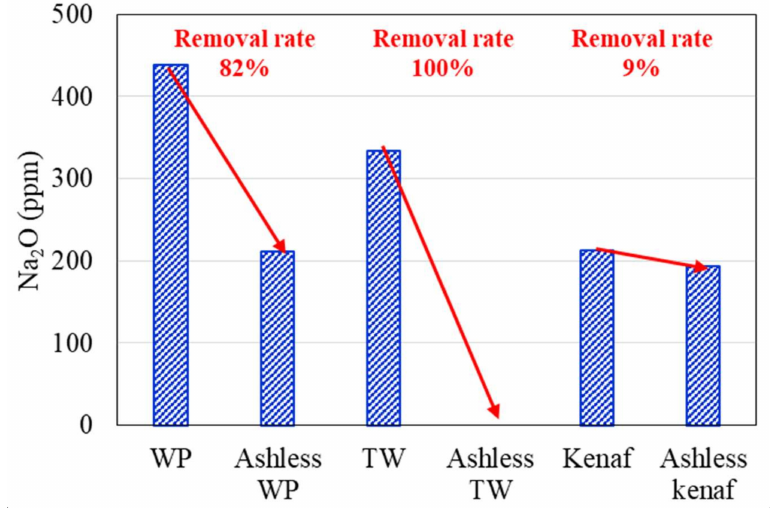
Figure 7. Na 2 O contents of three biomass types before and after the ALB